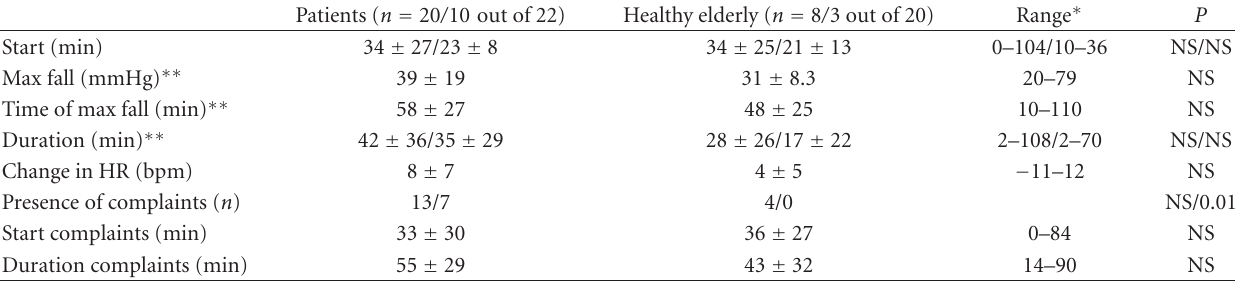
Table 3: Characteristics of the subjects (elderly patients and healthy elderly individuals) with postprandial hypotension defined as > 20/ > 30mmHg systolic fall.